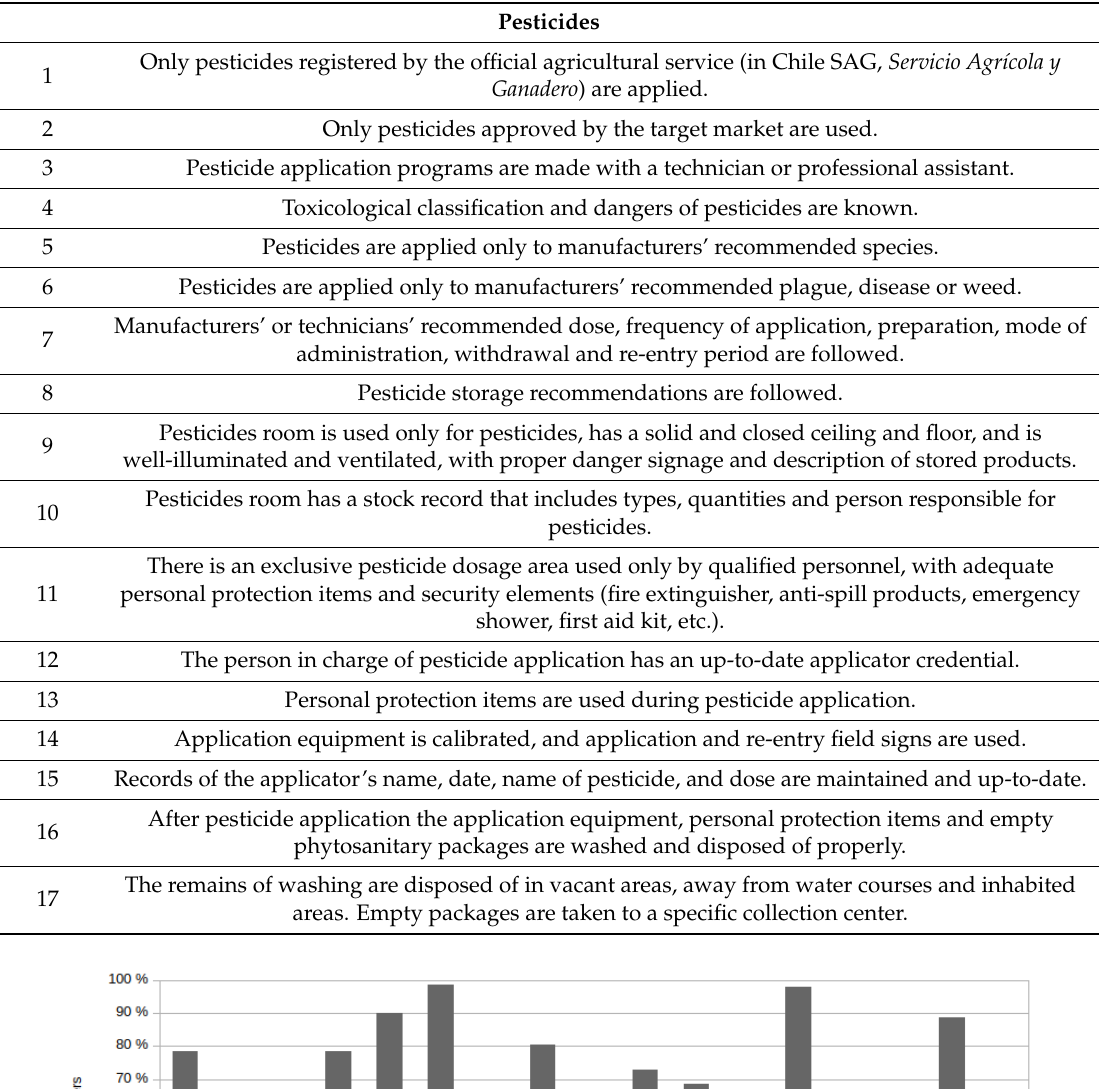
Table A2. Standard GPs for the use of pesticides in peasant family farming. Table B. Standard GPs for the use of pesticides in peasant family farming.